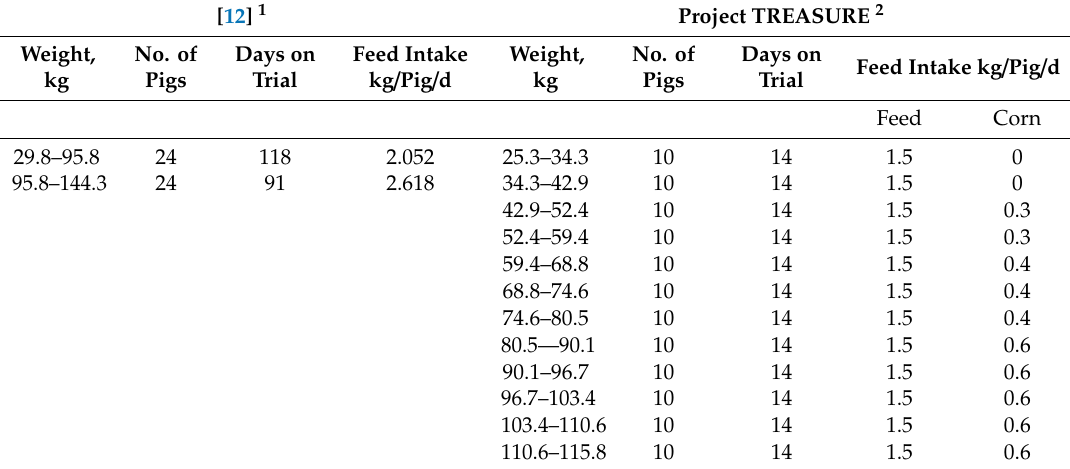
Table A3. Data on B í sara breed used for modelling.